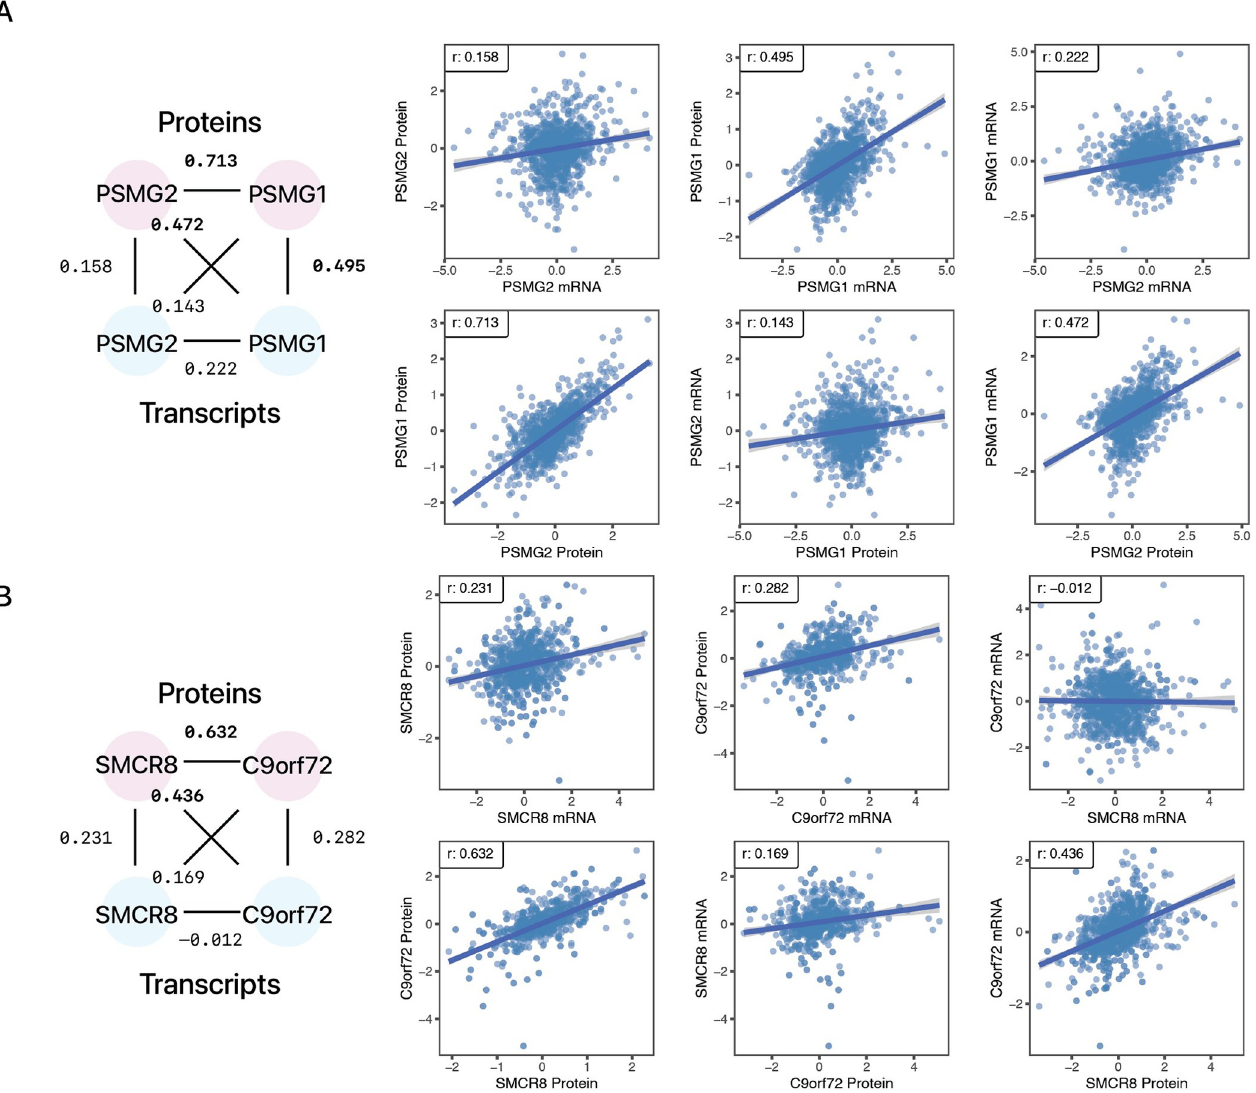
Fig 5. mRNA-Protein correlations of PSMG2 and SMCR8 with functionally associated proteins. Two examples of proteins whose abundance is better explained by another transcript are shown. A. PSMG2 protein level is predicted by PSMG1 transcript but not its own transcript. B. SMCR8 protein level is explained by C9orf72 transcript level but not its own transcript. Substantial correlations across transcripts and proteins ( � 0.4) are bolded.